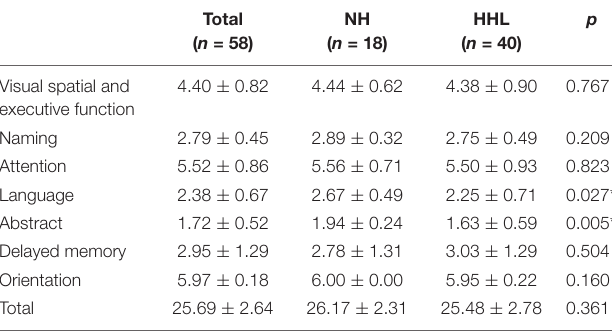
TABLE 4 | Cognitive function and different cognitive domains of the HHL and NH